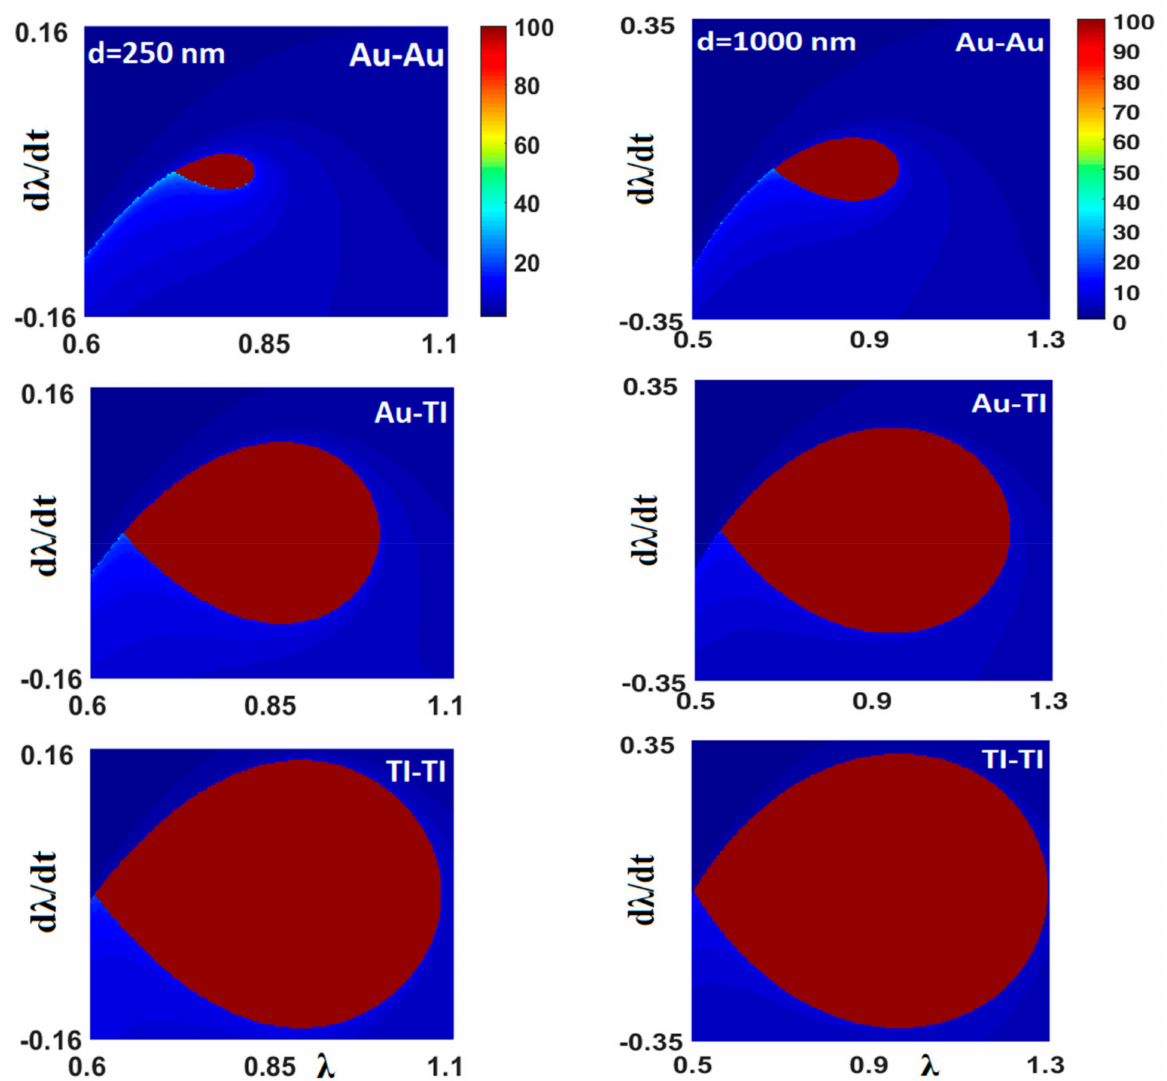
Figure 3. Contour plots of the transient times to stiction in the phase plane d λ /dt vs. λ for systems made of several pairs of interacting materials. The initial distance between the plates is indicated in the plots. Here, we considered δ Cas = 0.065 for d = 250 nm and δ Cas = 0.031 for d = 1000 nm. For the calculations, we used 150 × 150 initial conditions ( λ , d λ /dt). The red (elliptical in shape central area) region surrounded by the homoclinic orbit contains the initial conditions that lead to stable